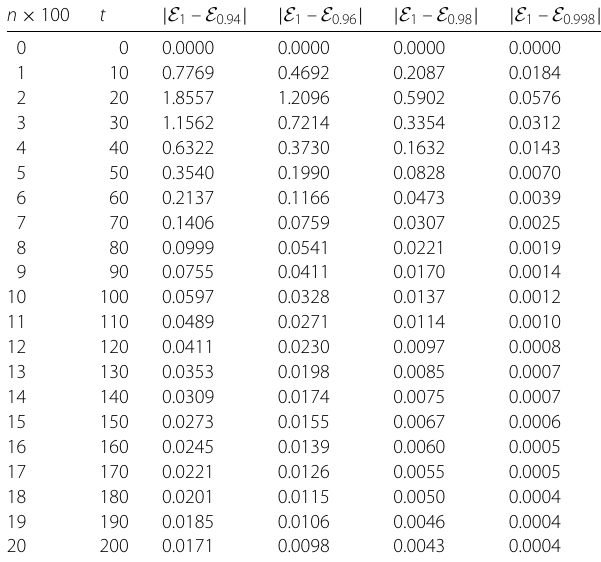
Table 3 The values of | E 1 – E φ | for φ = { 0.94,0.96,0.98,0.998 }